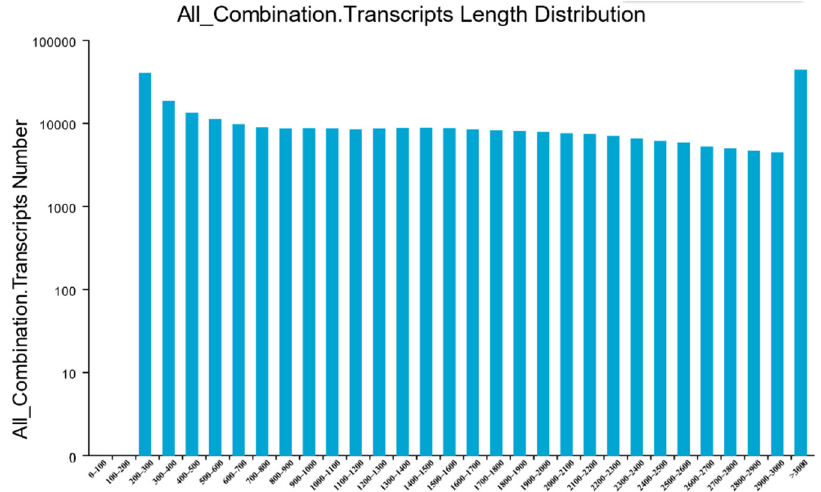
Figure 2. Length distribution of the unigenes isolated from the “Shanxin” poplar xylem. The length intervals of the unigenes are shown on the x-axis, and the number of unigenes is shown on the y-axis.